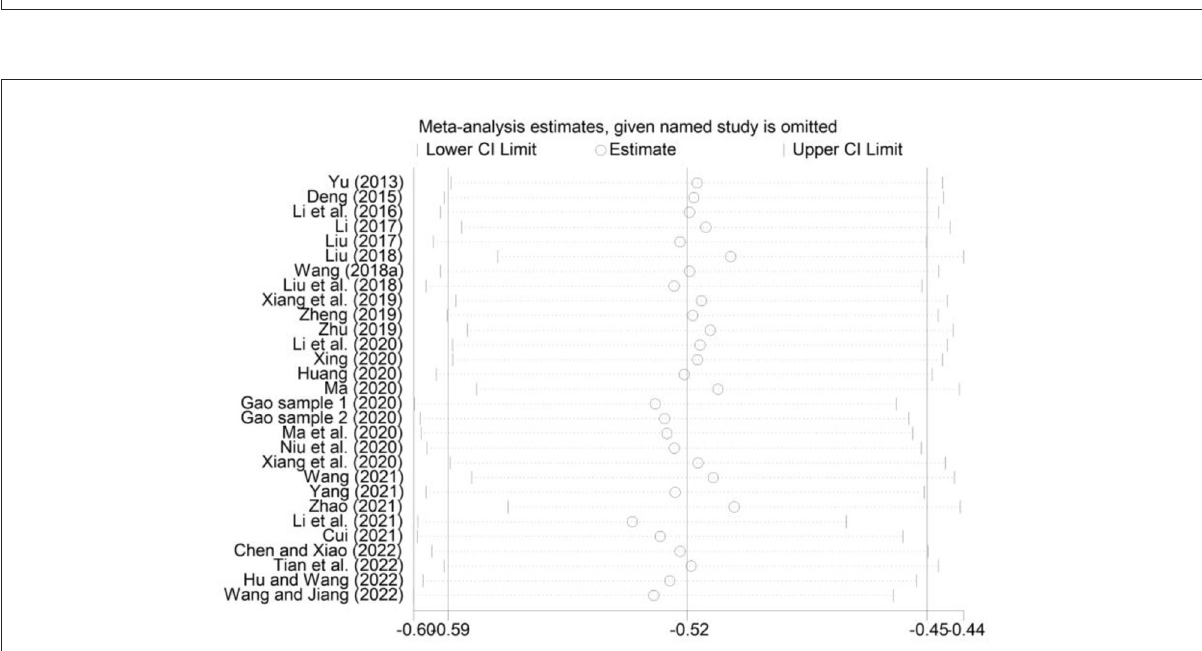
FIGURE6 Sensitivity analysis of the correlation between smartphone addiction and